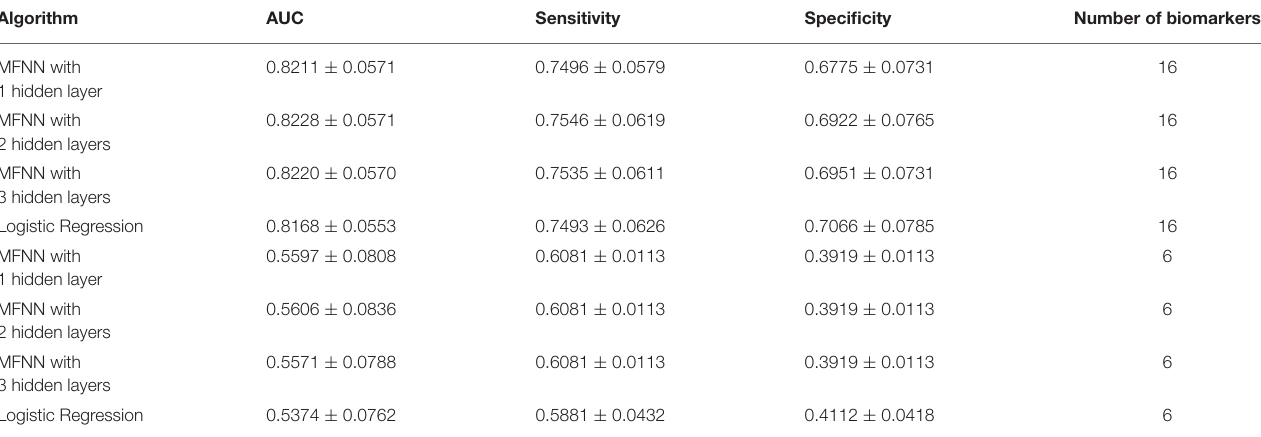
TABLE 4 | The results of repeated 10-fold cross-validation experiments for predicting treatment response using multilayer feedforward neural networks (MFNNs) and logistic regression with 16 biomarkers and 6 clinical biomarkers only.